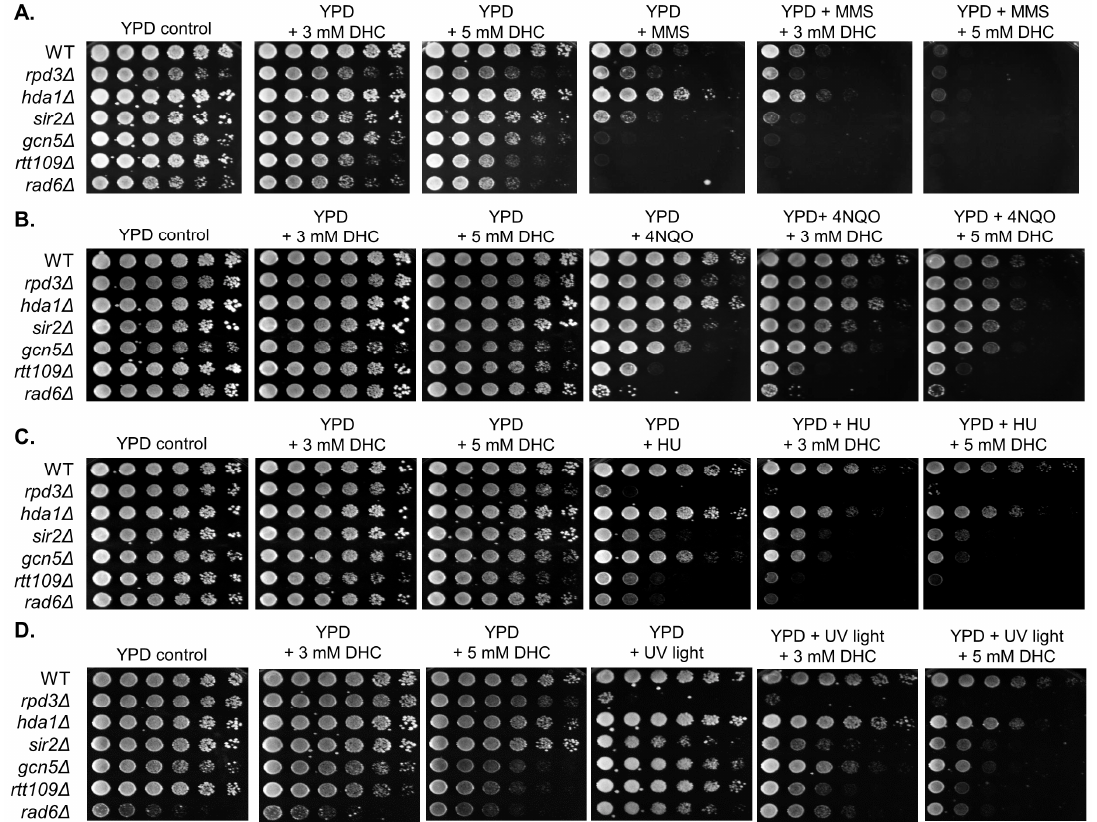
Figure 2. DHC sensitizes wild-type cells to DNA-damaging drugs. Five-fold serial dilution analysis of the indicated isogenic strains, including WT (BY4741), rpd3 ∆ (BY4741-rpd3), hda1 ∆ (BY4741-hda1), sir2 ∆ (BY4741-sir2), gcn5 ∆ (BY4741-gcn5), and rtt109 ∆ (BY4741-rtt109), shows their sensitivity to: ( A ) 0.02% MMS; ( B ) 0.1 µg/mL 4NQO; ( C ) 100 mM HU; and ( D ) 150 J/m 2 UV light with or without DHC. The cells were allowed to grow at 30 ◦ C for 3 days and were photographed for